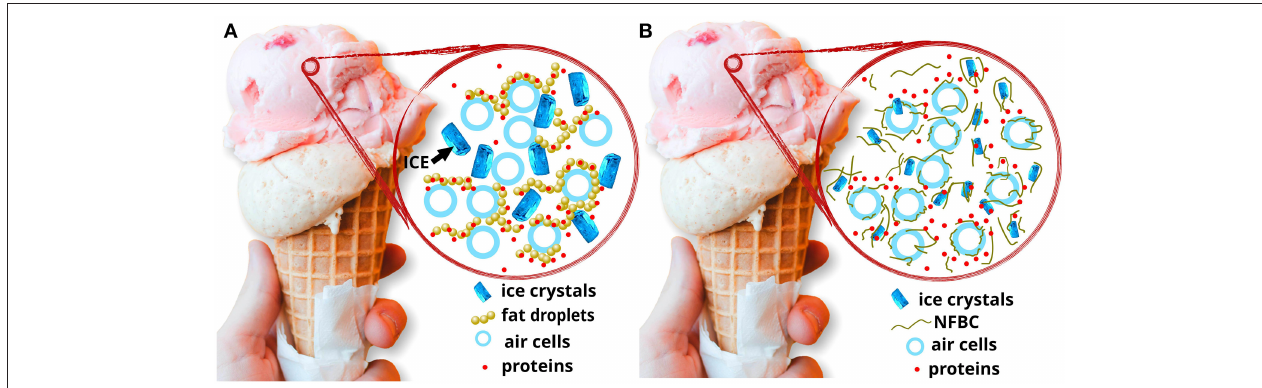
FIGURE 4 | (A) Schematic structure of an ice cream; (B) proposed schematic structure of an ice cream containing NFBC as a fat replacer and rheology modifier, with reduced iciness, and air cell structure kept by